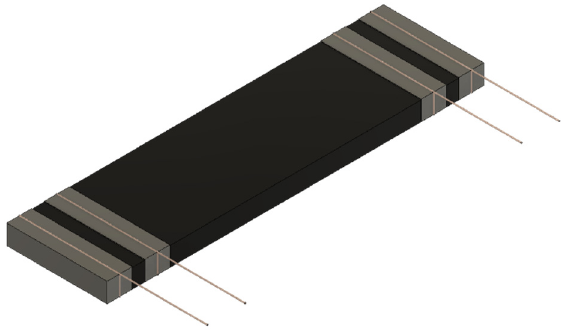
Figure 1. Schematics of electrode disposition in electrical conductivity measurements.